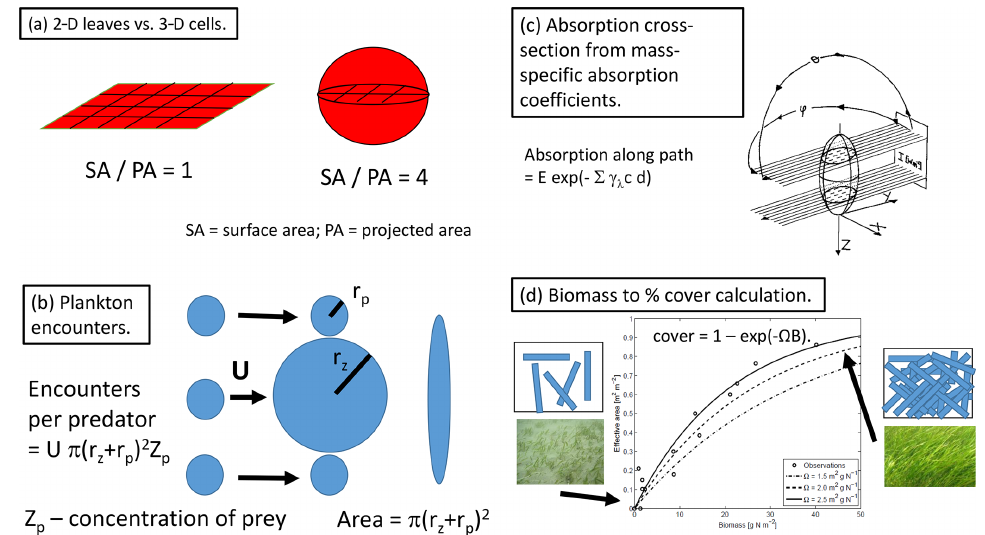
Figure 2. Examples of geometric descriptions of ecological processes. (a) The relative difference in the 2-D experience to nutrient and light fields of leaves compared to the 3-D experience of cells, as typified by the ratio of surface area (coloured) to projected area (hashed area). (b) The encounter rate of prey per individual predator as a function of the radius of encounter (the sum of the predator and prey radii) and the relative motion and prey concentration following Jackson (1995). (c) The use of ray tracing and the mass-specific absorption coefficient to calculate an absorption cross-section for a randomly oriented spheroid following Kirk (1975). (d) Fraction of the bottom covered as seen from above as a result of increasing the number of randomly placed leaves (Baird et al., 2016a), based on the assumption that leaves are randomly placed; the cover reaches 1 − exp ( − 1 ) = 0 . 63 when the sum of the shaded areas induced by all individual leaves equals the ground area (i.e. a leaf area index of